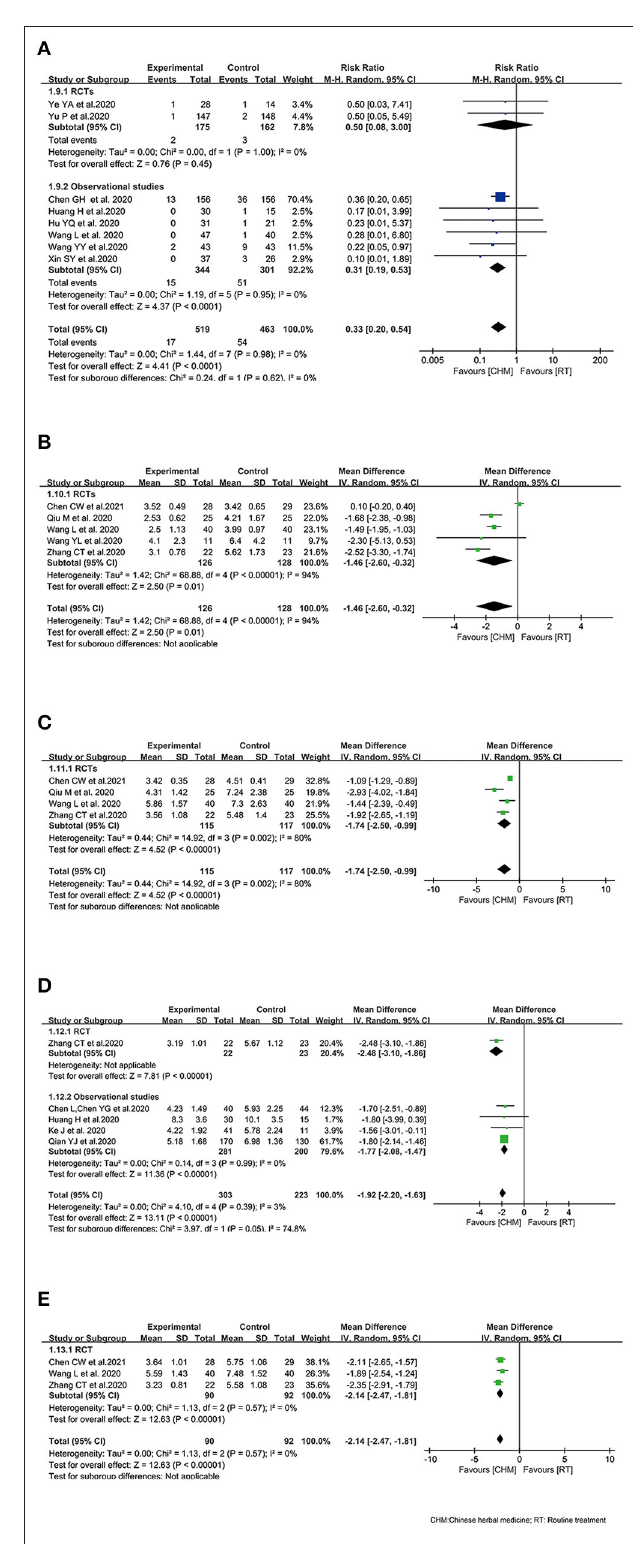
FIGURE 3 | Effect of Chinese herbal medicine as an adjuvant on clinical profiles during COVID-19. (A) All-cause mortality. (B) Time to the remission of fever. (C) Time to cough remission. (D) Time to the remission of chest tightness. (E) Time to fatigue remission.